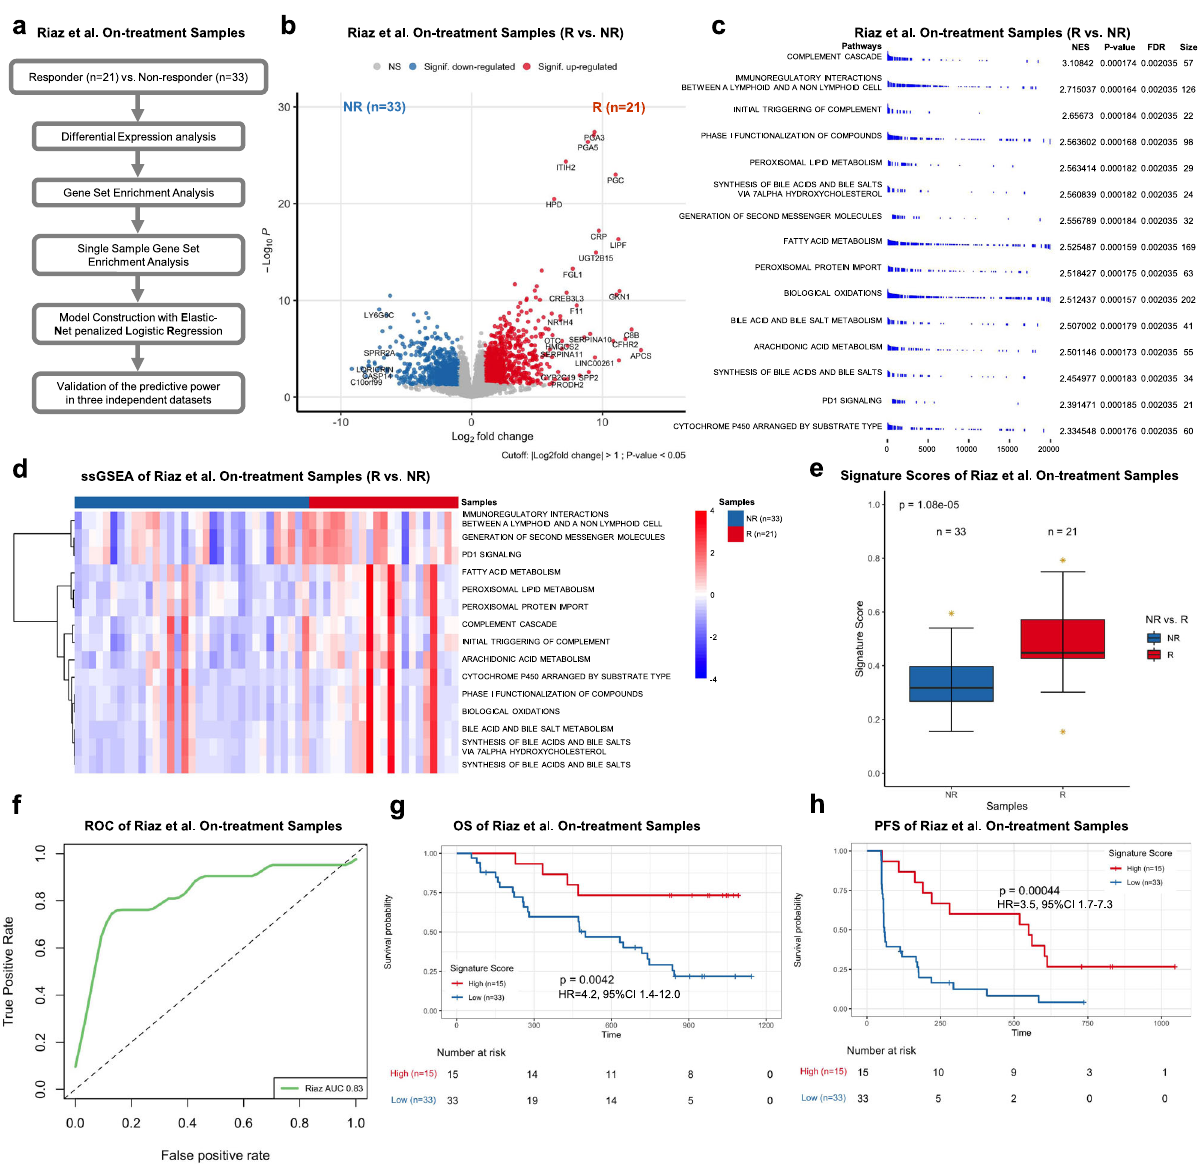
Fig. 4 Pathway-based super signature for on-treatment samples. a The computational pipeline of model construction based on on-treatment samples in the Riaz et al. cohort. b The volcano plot of differential gene expression analysis between on-treatment responders (R) and nonresponders (NR) in the Riaz et al. cohort. Log2Fold change (FC) was calculated. The two-sided Wald test was implemented to test if no differential expression between responder and nonresponders. The blue dots represent signi fi cantly downregulated (Signif. downregulated) genes (log2Fold Change < − 1, P -value < 0.05). The red dots represent signi fi cantly upregulated (Signif. upregulated) genes (log2Fold Change > 1, P -value < 0.05). The gray dots represent nonsigni fi cant (NS) genes. c The GSEA results of 15 candidate pathways. Normalized Enrichment Score (NES) and the size of leading-edge geneset are calculated. The permutation based P -value shows the statistical signi fi cance of the enrichment score. The number of permutation is 10,000. False discovery rate (FDR) is the estimated probability that the normalized enrichment score represents a false positive fi nding. d The heatmap of ssGSEA values of on-treatment responders (R) and nonresponders(NR) in the Riaz et al. cohort. Nonresponders are presented on the left side, and responders are presented on the right side. FDR-corrected two-sided Welch t -test was conducted to compare ssGSEA values between R and NR samples, only FDR < 0.05 showed here. e The boxplot of on- treatment sample ’ s Pathway-based super signatures (PASS-ON) signature score of responders (R) and nonresponders (NR) with the number of samples showed in the Riaz et al. cohort. The P -value was computed via a one-sided rank-sum test. Boxplot center lines indicate medians, box edges represent the interquartile range, whiskers extend to the minimum and maximum, and the outliers are plotted individually using the ‘ * ’ symbol. f ROC and AUC of PASS- ON on the on-treatment samples in the Riaz et al. cohort. g, h The Kaplan – Meier analysis of overall survival (OS) ( g ) and progression-free survival (PFS) ( h ) of on-treatment samples in the Riaz et al. cohort. The two-sided log-rank test compared high and low subgroups based on the mean of on-treatment samples odd ratio as cutoff. Hazard ratio (HR) was calculated and shown with con fi dence interval (CI). Source data are provided as a Source Data fi